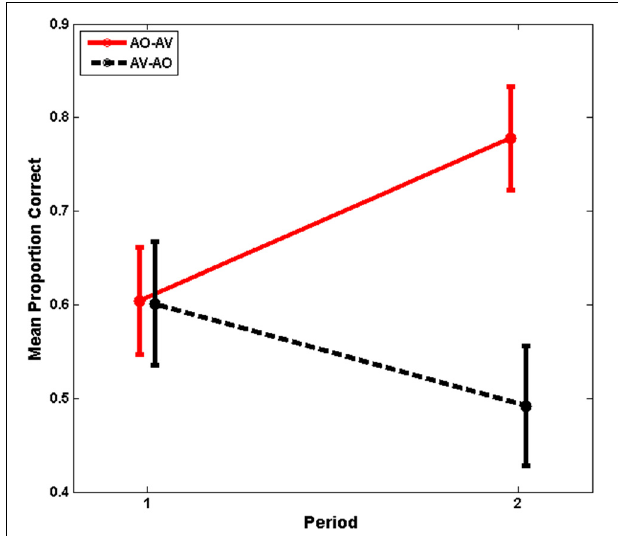
FIGURE 4 | Experiment-1 mean training scores with standard errors of the mean. Period-1 training scores were the same independent of training modality, but training scores diverged at Period 2, with higher mean scores during AV